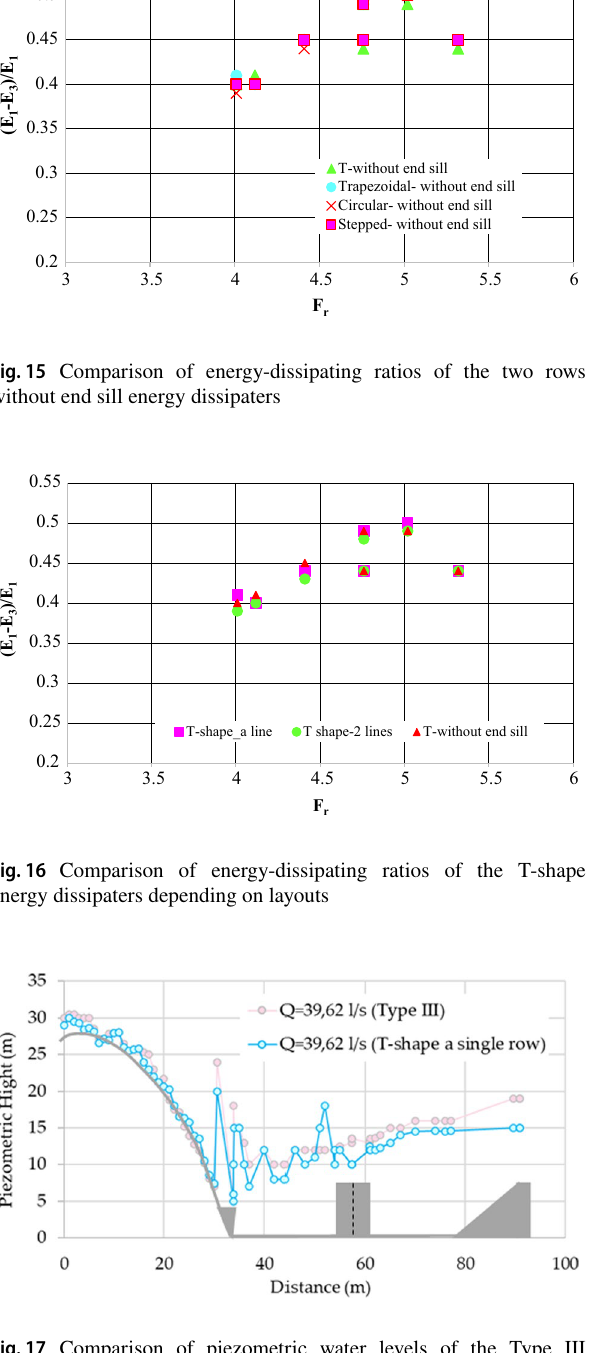
Fig. 17 Comparison of piezometric water levels of the Type III energy-dissipating pool which is with and without T-shape a single- row baffle blocks tested in the experimental